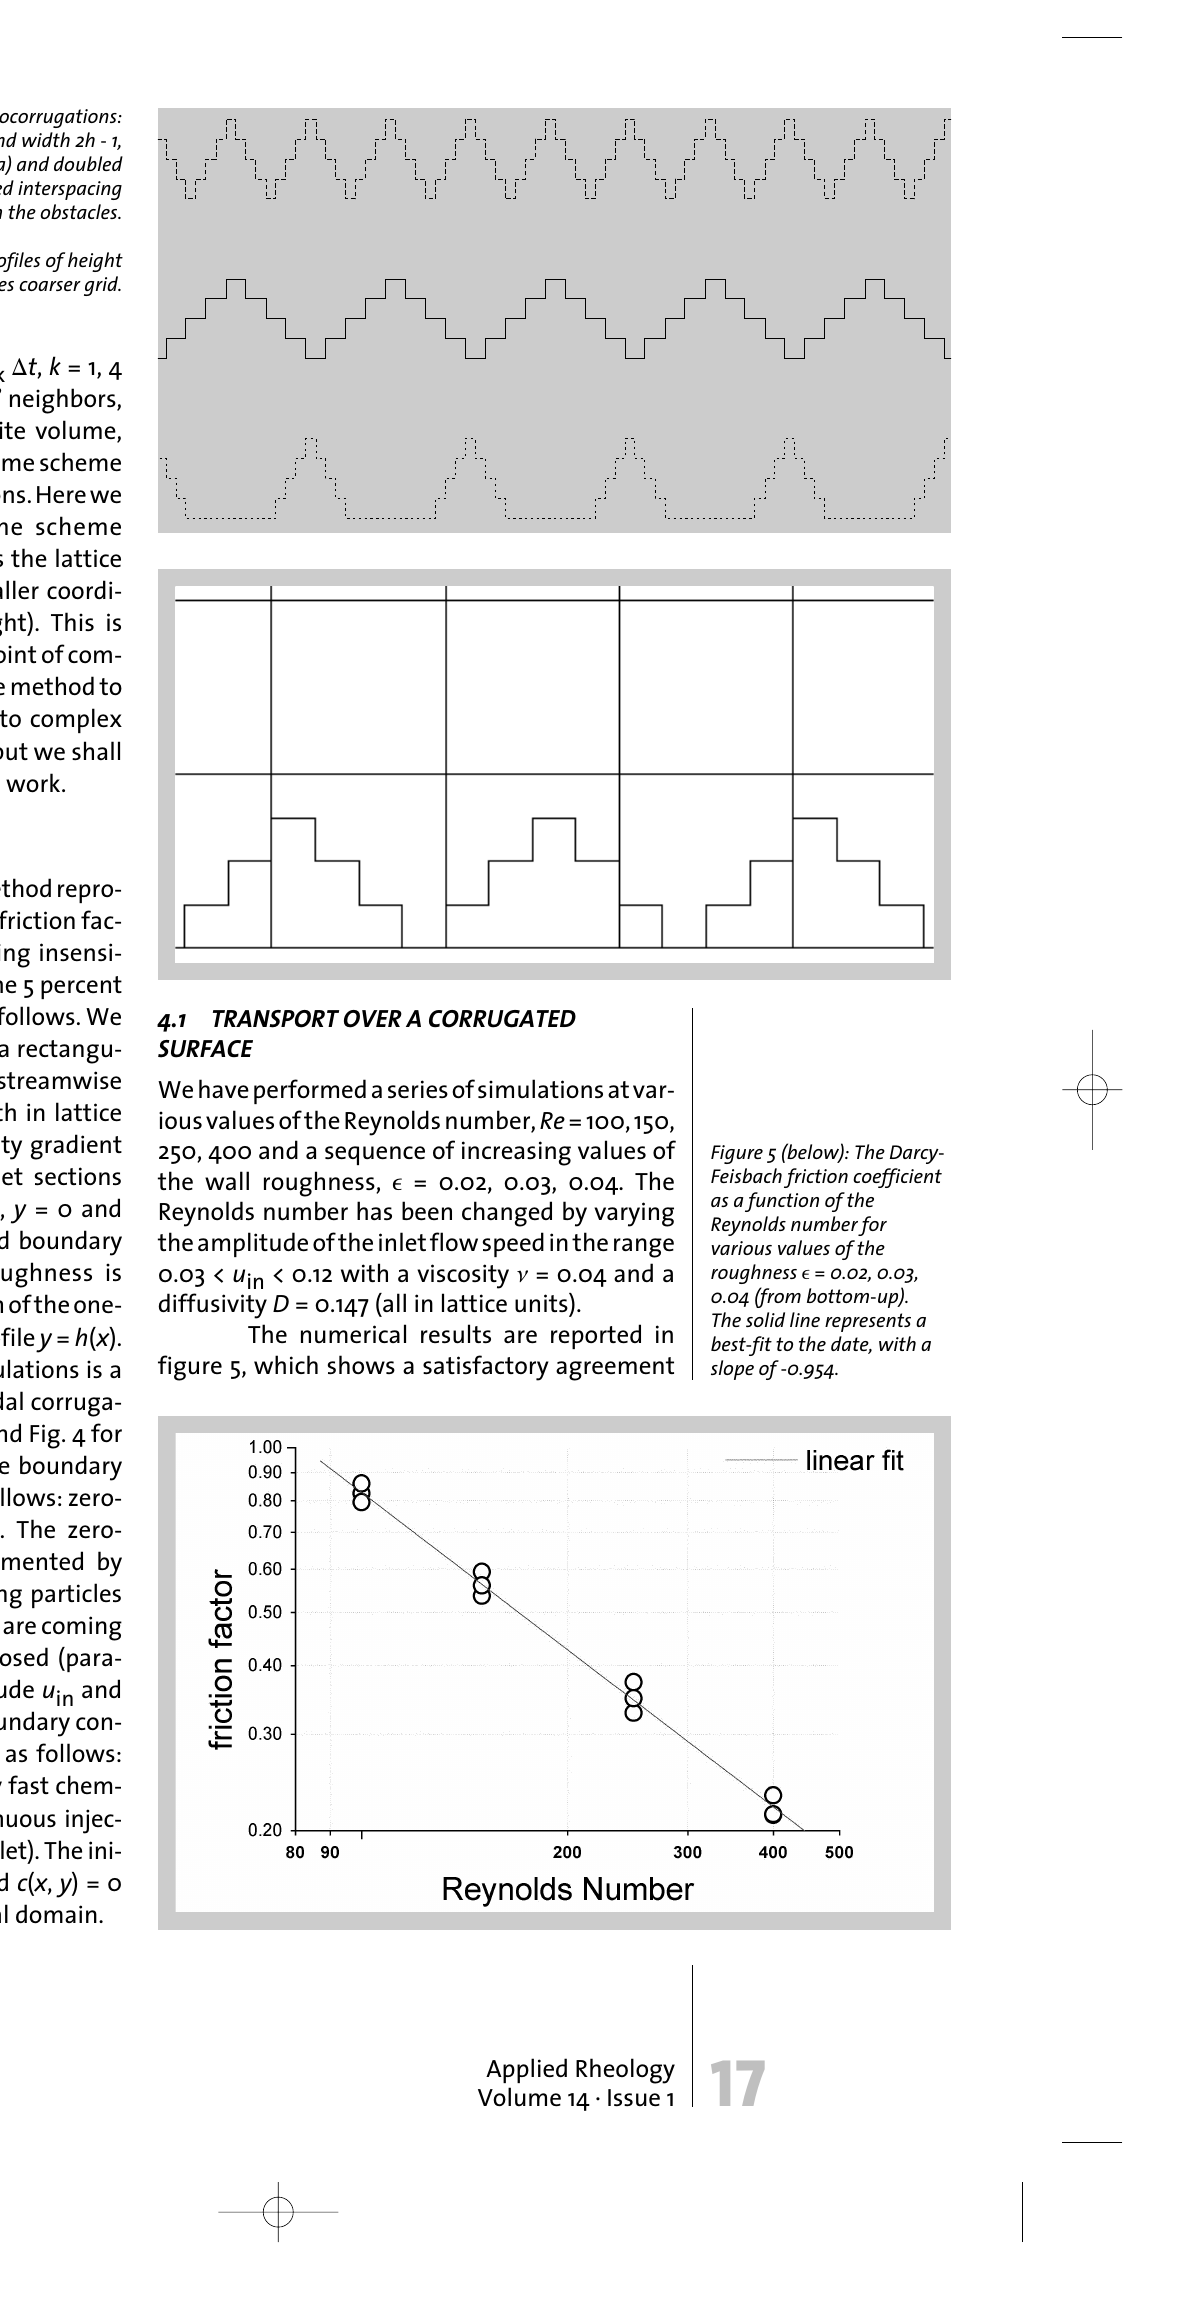
Figure 4 (middle): Trapezoidal profiles of height h = 3 embedded into a 4 times coarser grid.